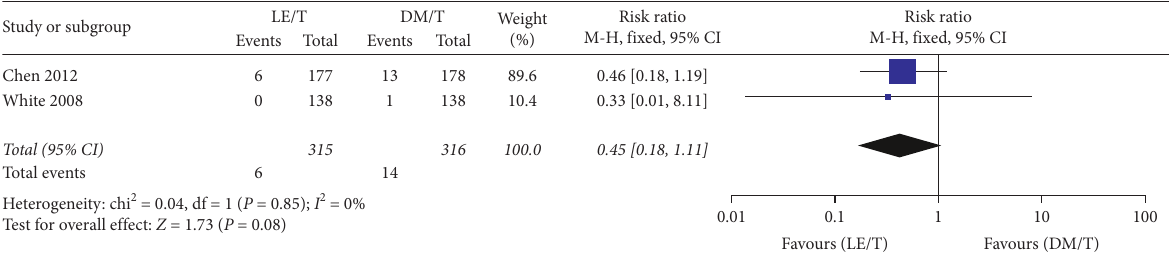
Figure 11: The incidence of elevating intraocular pressure (by more than